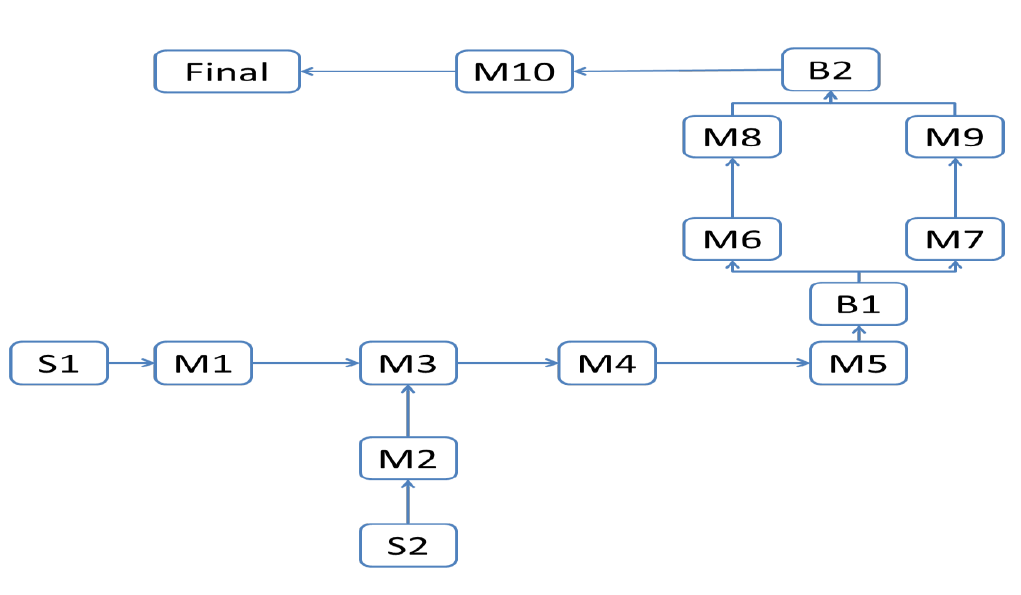
Figure 2: Design of the production line (M: Machine; S: Source; B: Buffer)